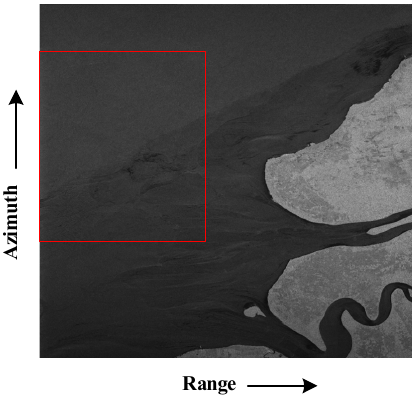
Figure 18. Real data from the two-channel along-track InSAR mode of the Gaofen-3 spaceborne SAR system (size: 13182(azimuth)*15316(range)).